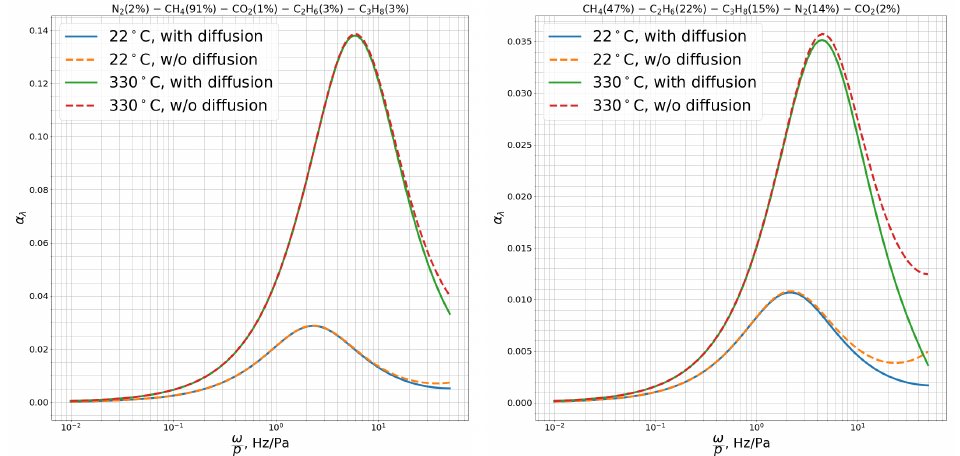
Figure 9. Attenuation coefficient in five-component mixtures. The effect of diffusion processes. Solid lines: diffusion is included; dashed lines: no diffusion and thermal diffusion. ( Left ) N 2 (2%)– CH 4 (91%)–CO 2 (1%)–C 2 H 6 (3%)–C 3 H 8 (3%) and ( right ) N 2 (14%)–CH 4 (47%)–CO 2 (2%)–C 2 H 6 (22%)– C 3 H 8